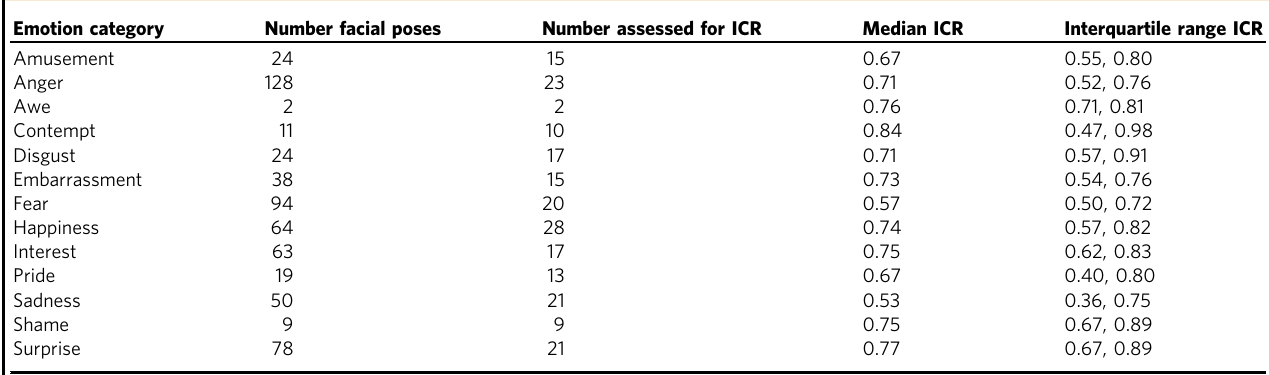
Table 2 Inter-coder reliability per emotion